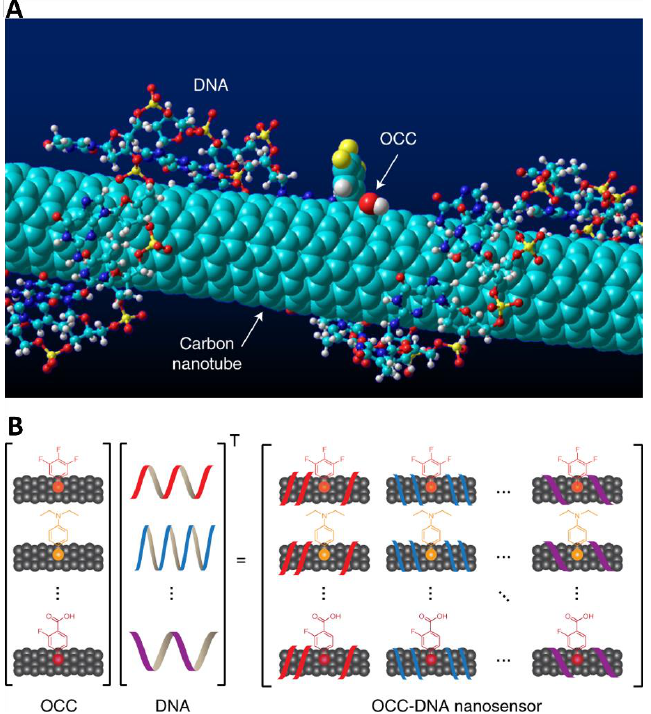
Figure 3. Molecular model and array construction of OCC-DNA nanosensor elements created by Kim et.al. [138]. ( A ) Fabricated molecular model of a single OCC-DNA nanosensor with ssDNA wrapped around a semi-conducting single-walled nanotube (SWNCT) modified with organic color sensors (OCC). ( B ) Nanosensor array construction is generated from a matrix combination of OCC- modified SWNCTs with DNA. Used with permission.